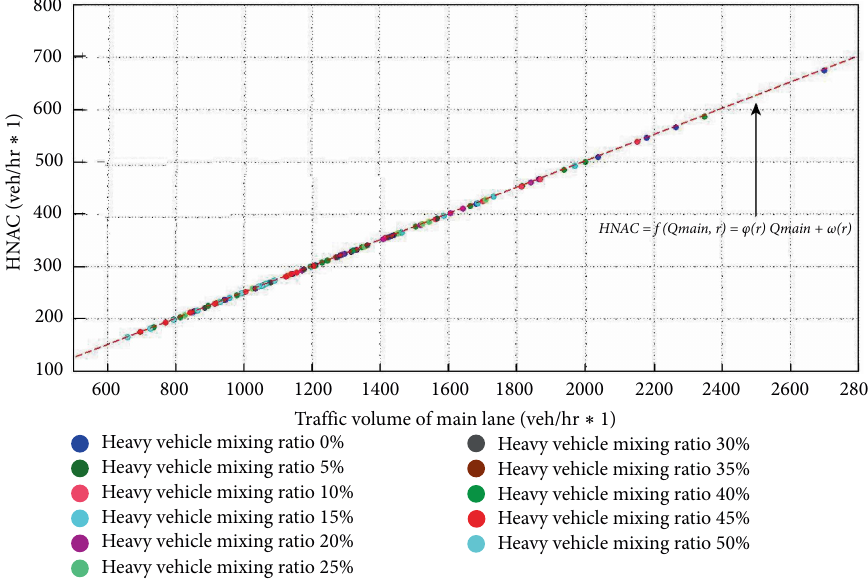
Figure 10: Linear fit of equation